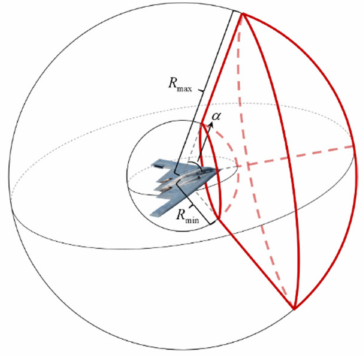
Figure 3. Attack zone of a UCAV.